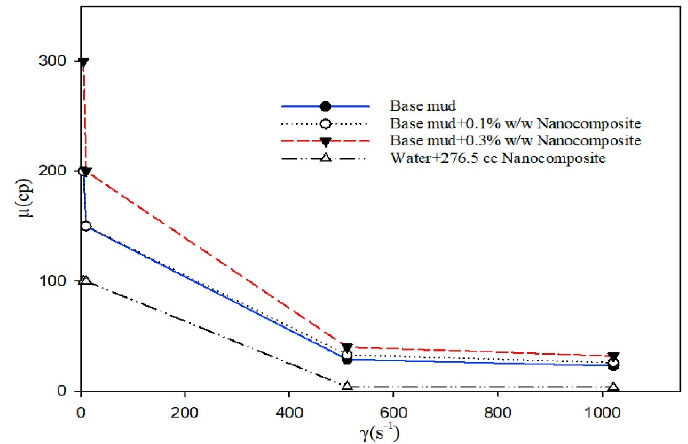
Figure 8. Viscosity versus shear rate using different concentrations of nanocomposite. Higher nanocomposite concentration results in a significant increase in viscosity [106].